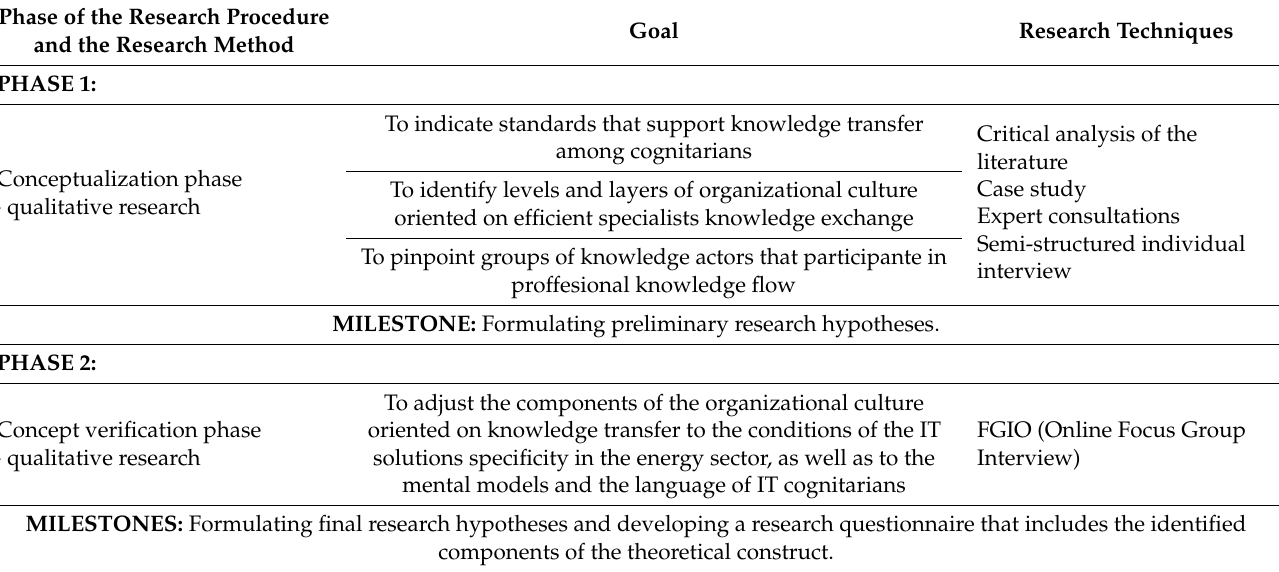
Table 1. Research procedure—stages, tools,